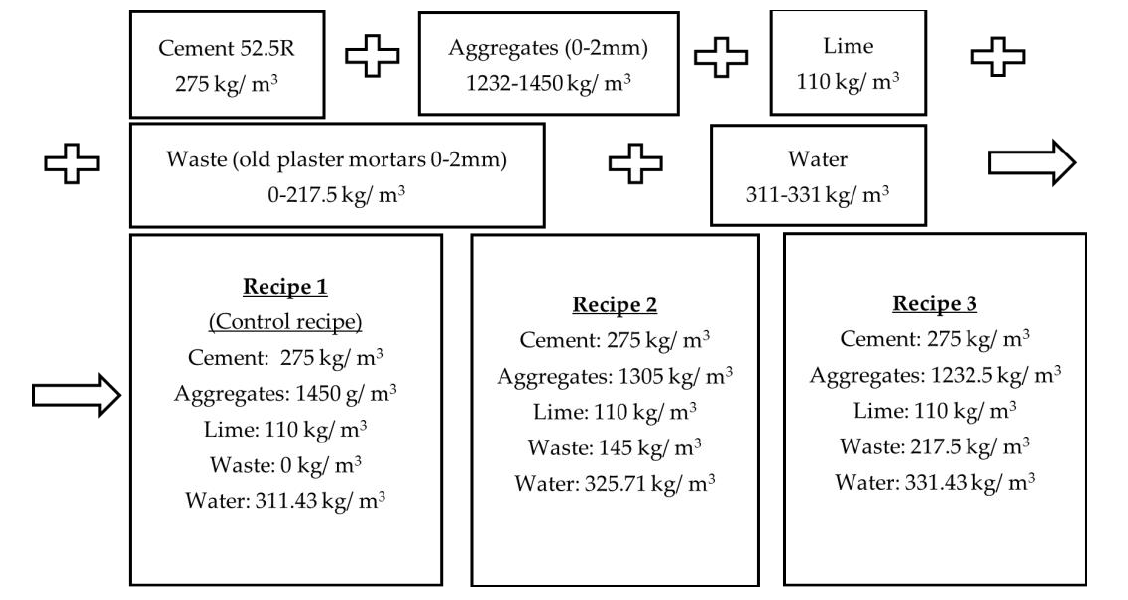
Figure 3. Graphic diagram of the materials used and the recipes. Table 1. Essential characteristics and performance of